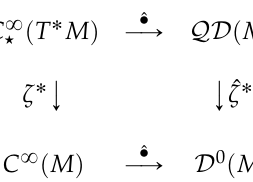
Classical Quantum